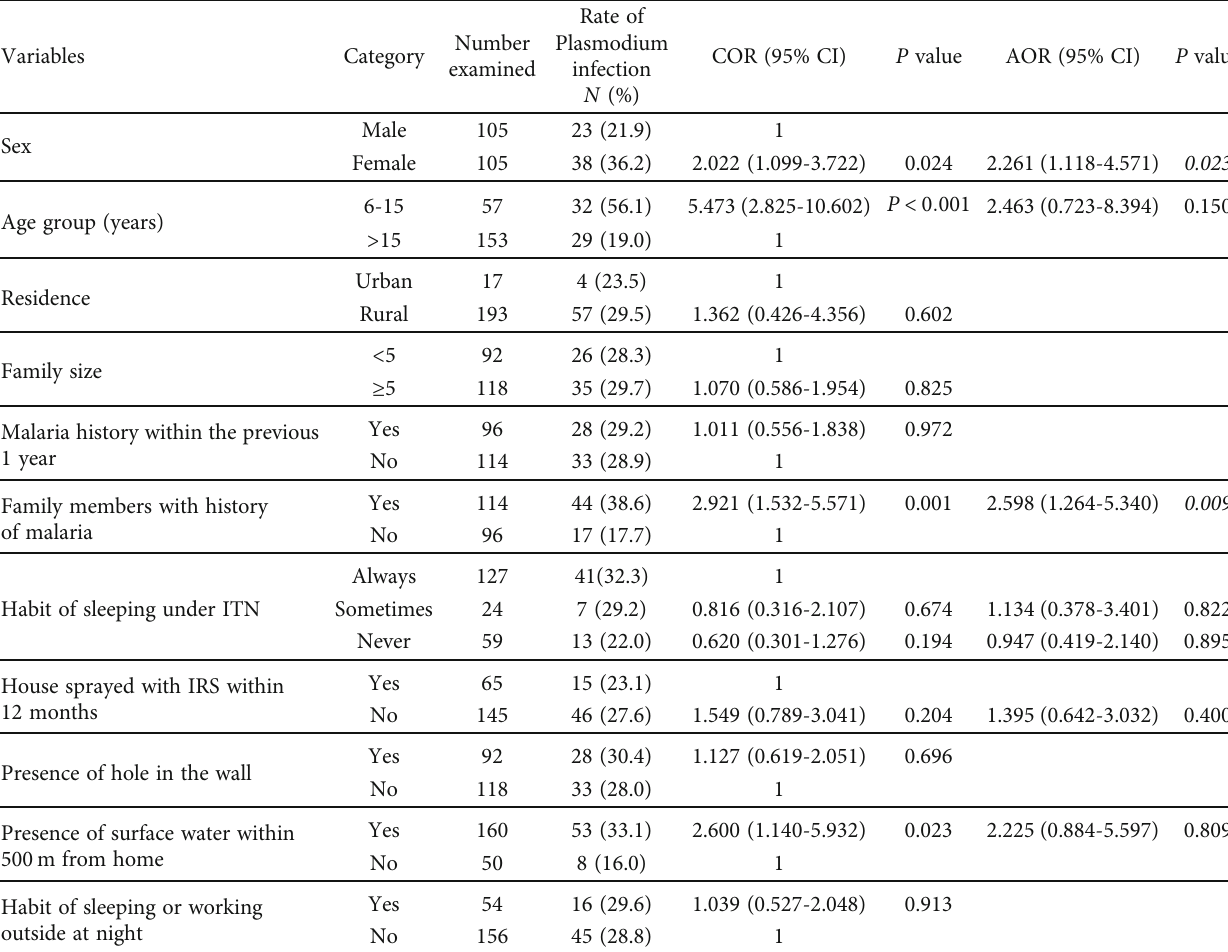
Table 5: Bivariate and multivariate logistic regression analysis of factors associated with malaria among febrile patients attending Hamusit Health Center, Northwest Ethiopia, from February to March